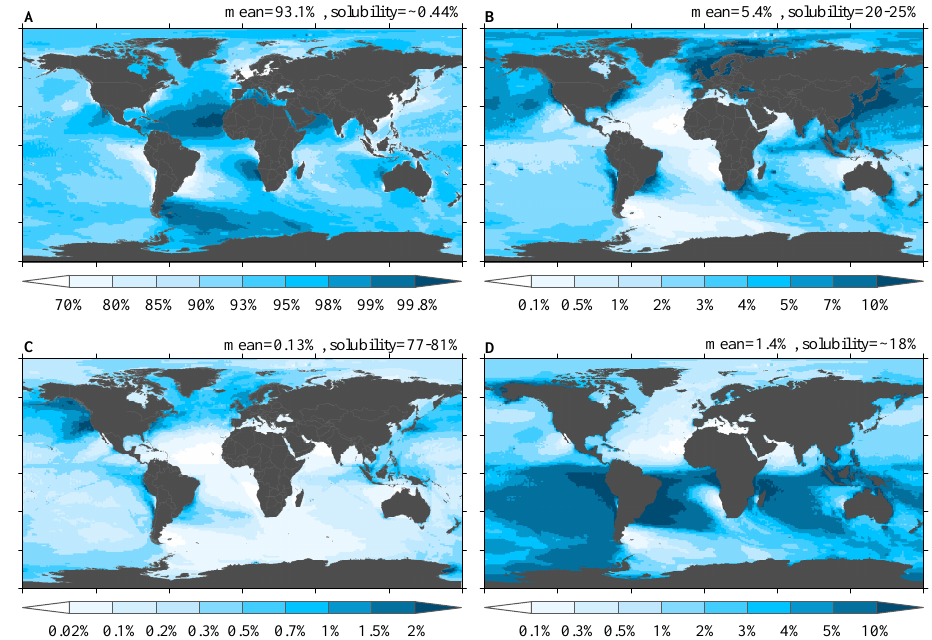
Figure 17 Figure 17. Relative contributions of atmospheric Fe deposition over oceans by mineral sources (a) and combustion of coal (b) , oil (c) and biomass (d) . The average contribution over the oceans and the measured Fe solubility are provided in the panel descriptions. Colour scales differ on each plot.